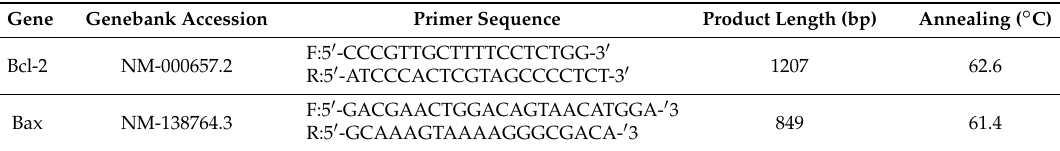
Table 1. Real-time PCR primers and